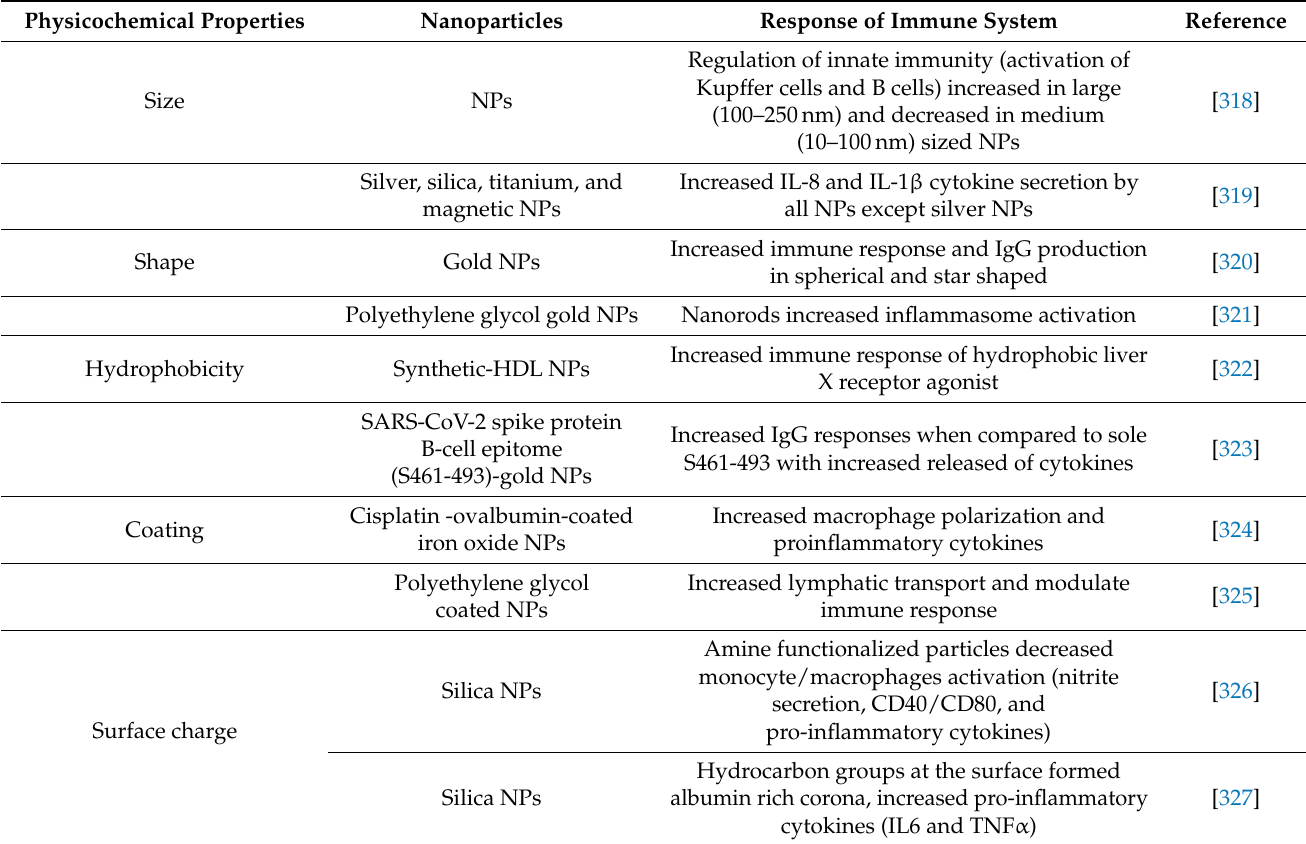
Table 5. Effect of physicochemical properties of NPs on